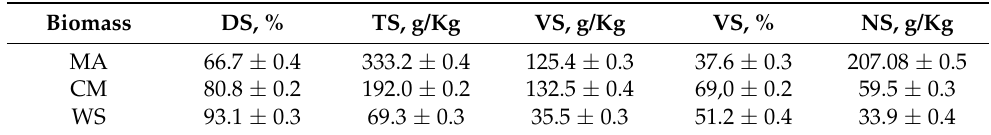
Table 1. Physical parameters of MA and